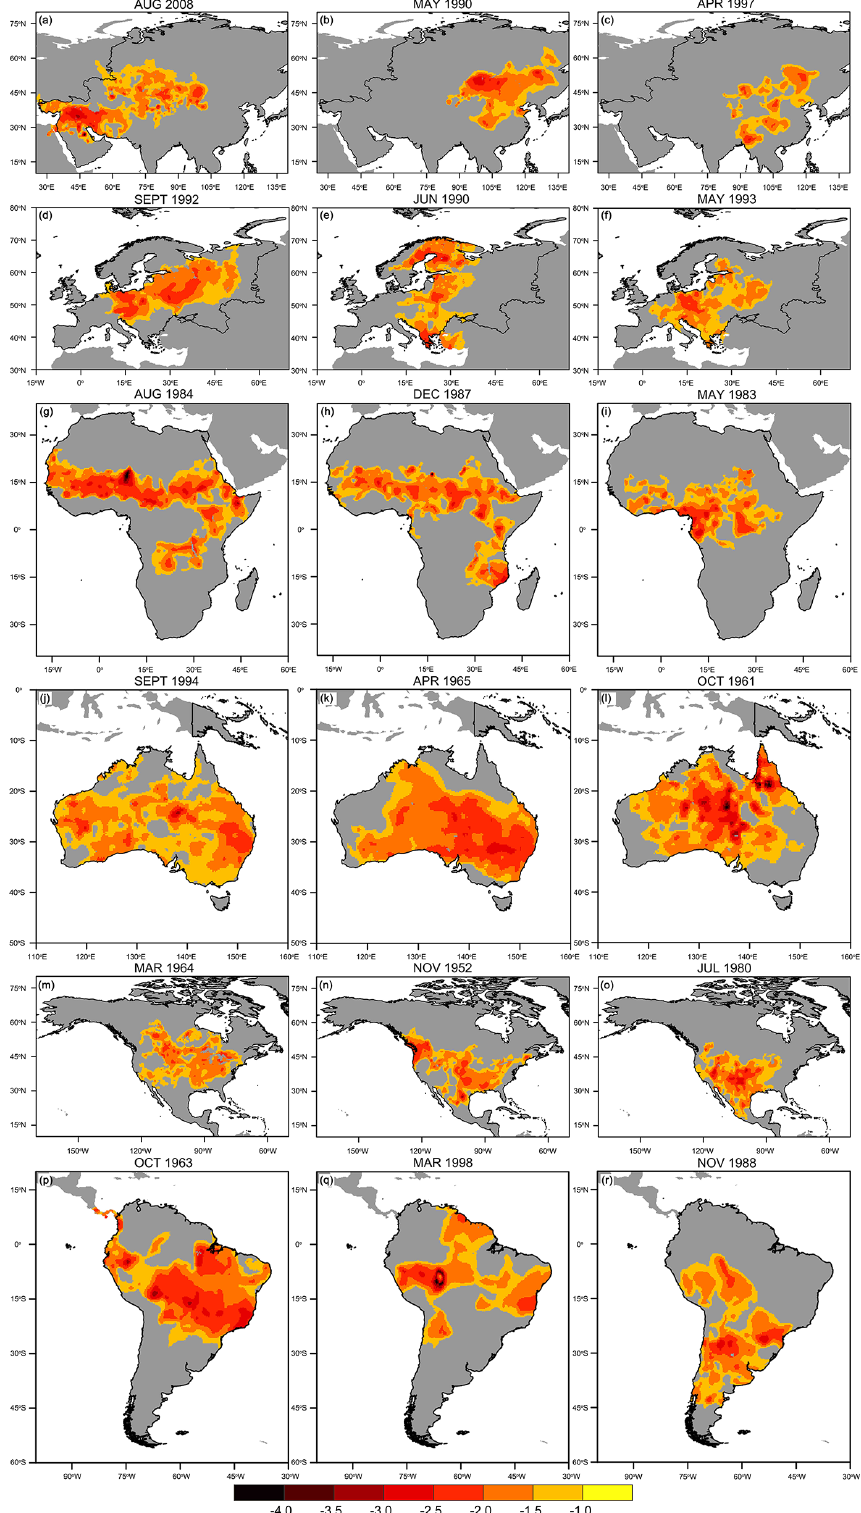
Figure 10. Spatial distribution and severity of the major large-scale drought events for Asia, Europe, Africa, Oceania, North America, and South America. Three out of the top five drought events were selected here for each continent. The geographic coordinate system is used in this